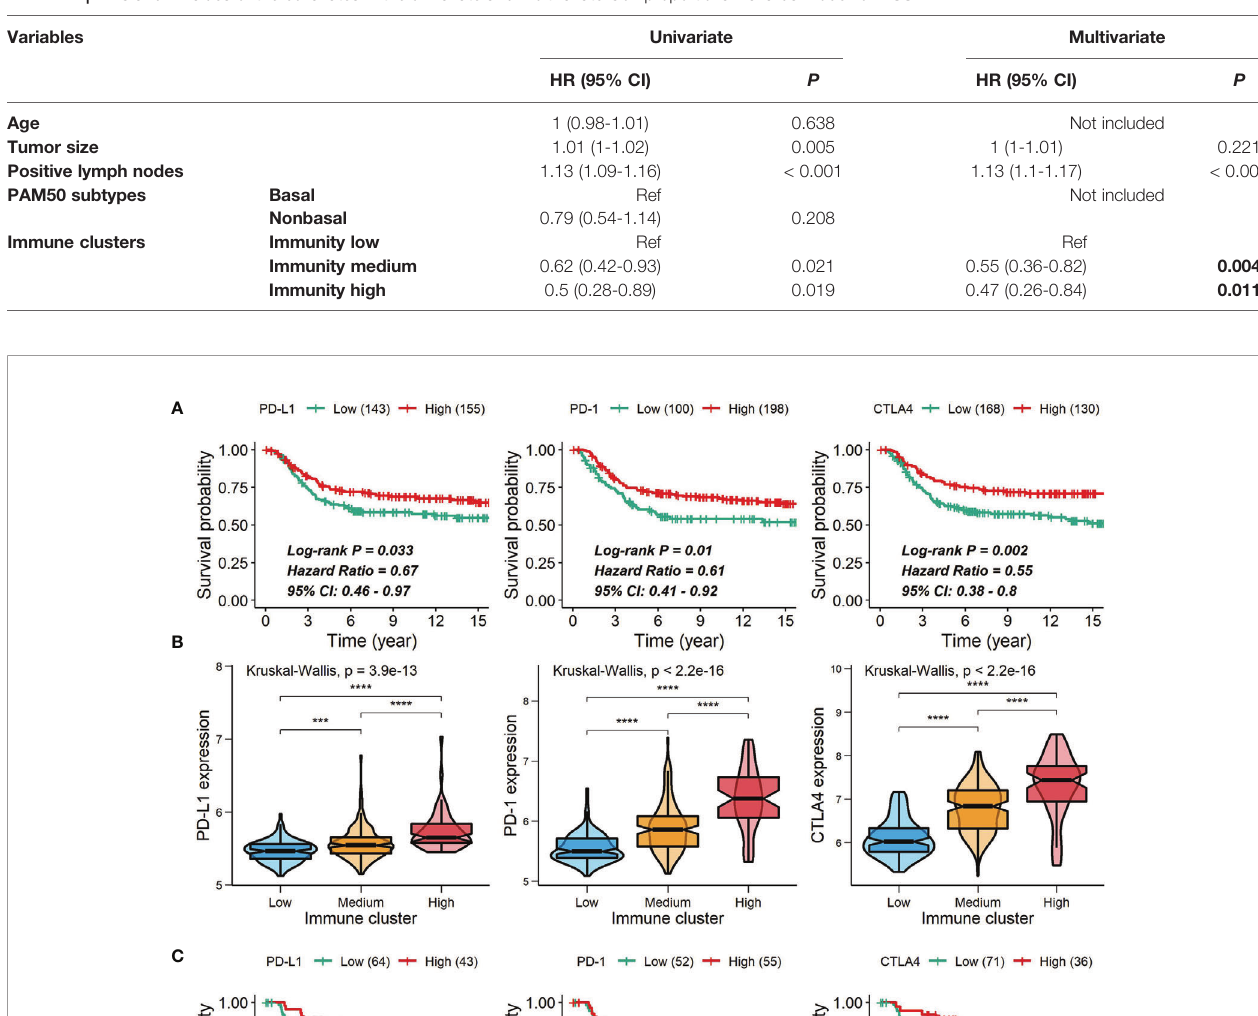
TABLE 2 | HRs and P values of the covariates in the univariate and multivariate Cox proportional hazards model for DSS.